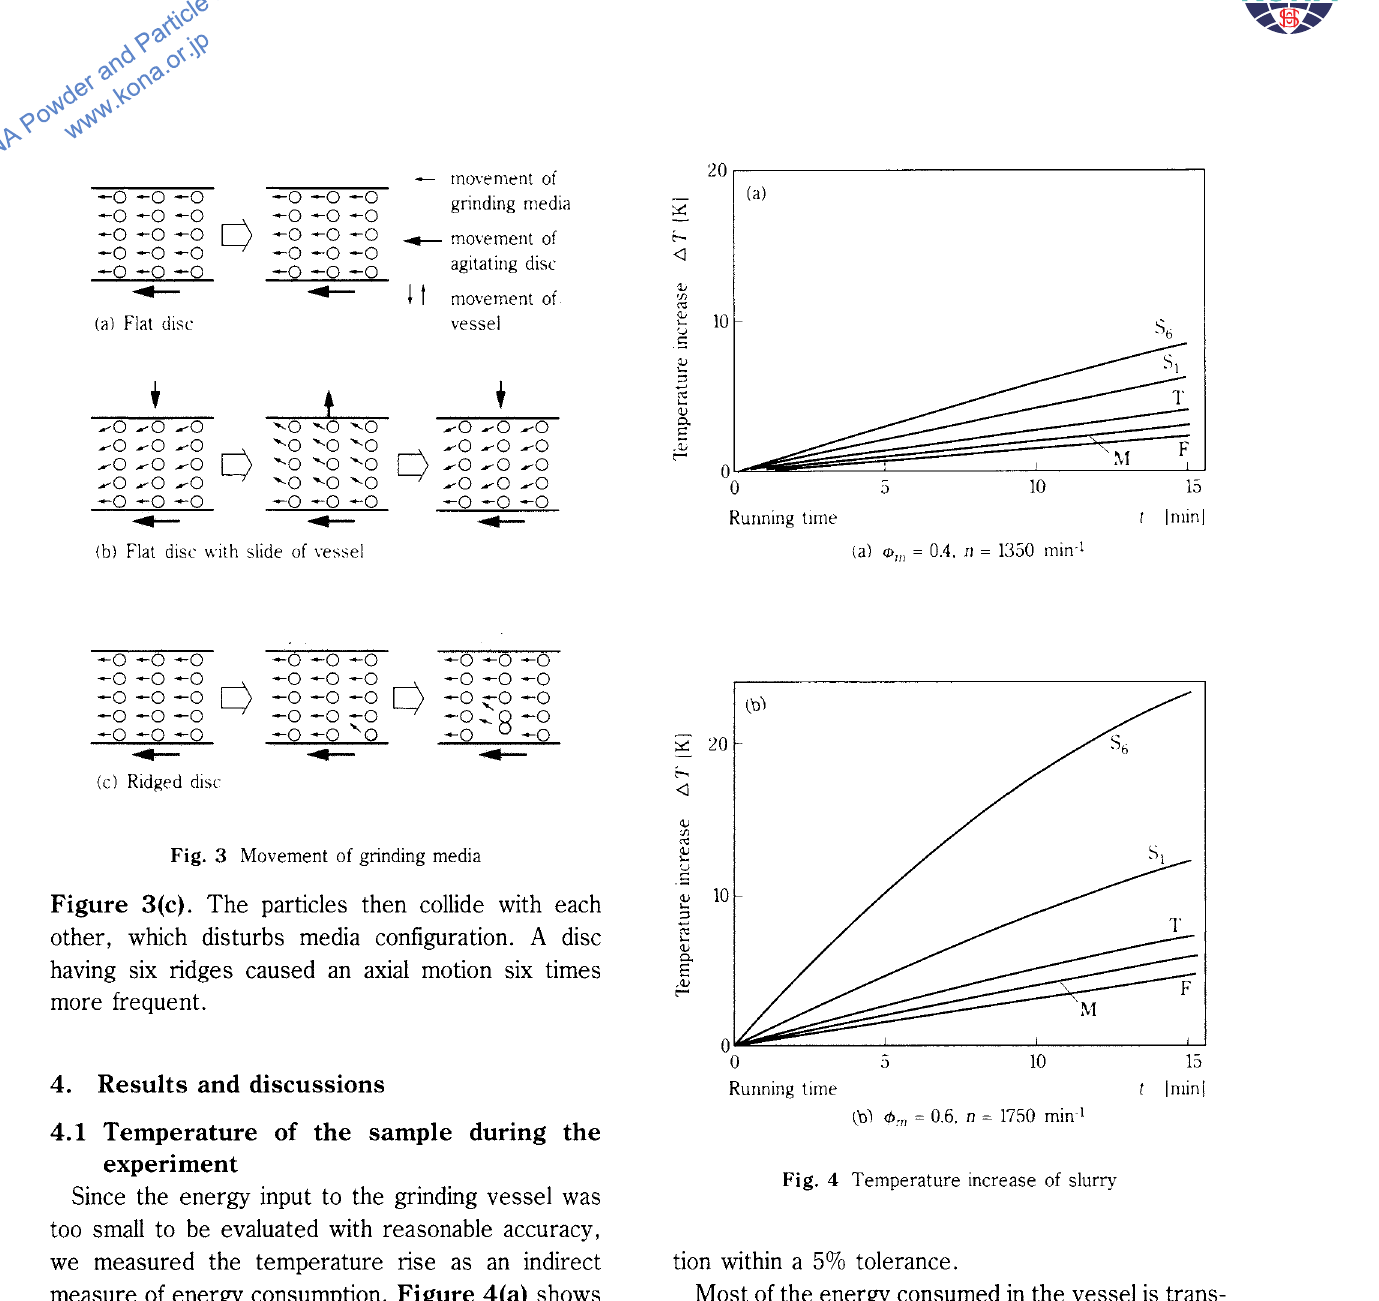
Fig. 4 Temperature increase of